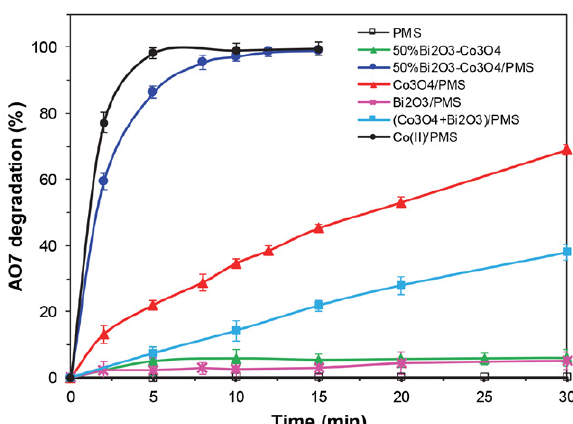
Fig. 5. Removal profiles of AO7 in different systems. Reaction con- ditions: [AO7] o = 50 mg/L; [PMS]/[AO7] = 6; [Catalyst]= 0.1 g/L; [Co 2+ ] = 0.39 mg/L; initial pH = 3.04; T = 293